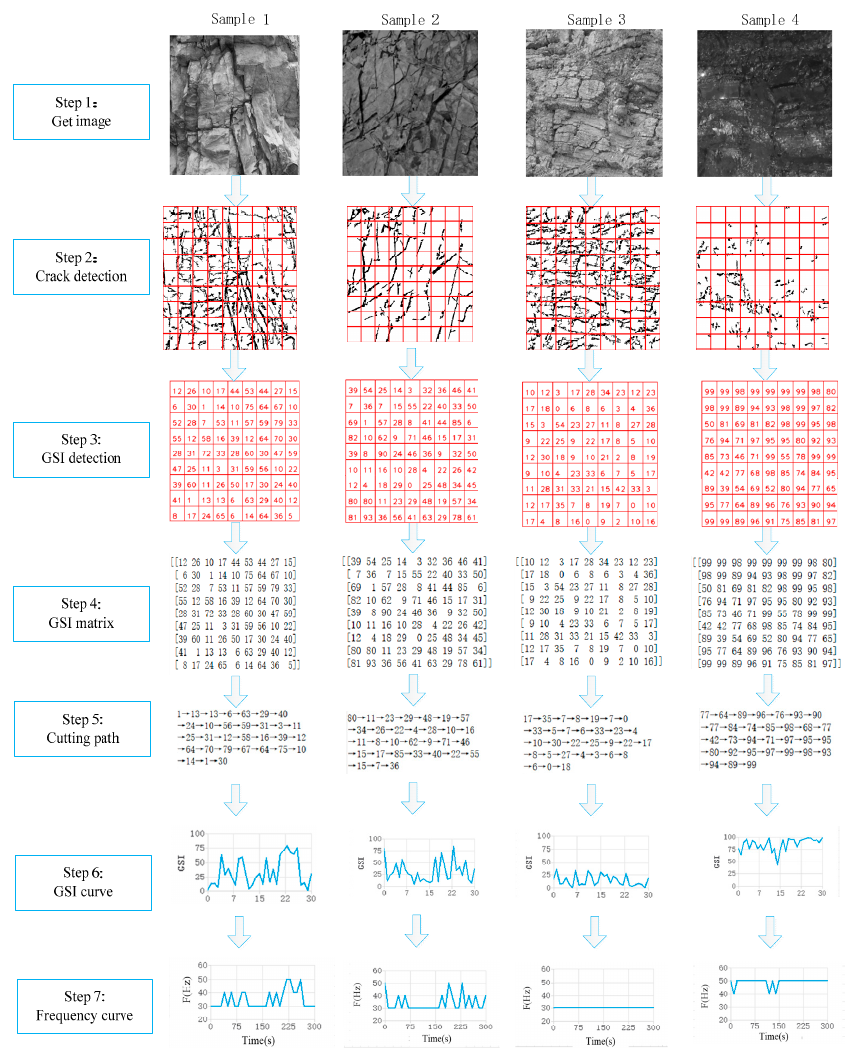
Figure 11. Vision-based cutting speed control steps